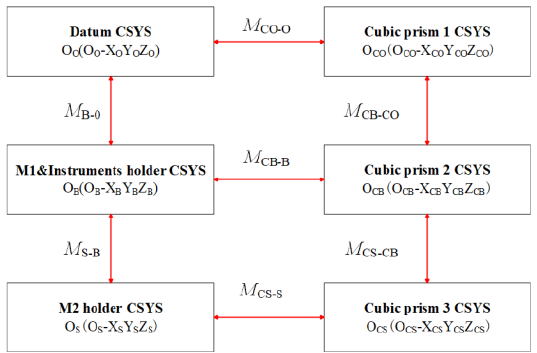
Figure 3. Coordinate system transfer relations.